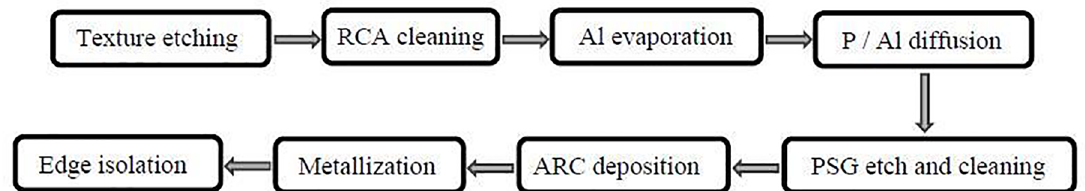
Figure 1. Sequence of the fabrication process of n + pp + silicon solar cells in mc-Si wafers with phosphorus and aluminum diffusion in the same thermal step. Table 1. Average values of the sheet resistance (R efficiency (η) of the solar cells as a function of POCl C POCl3